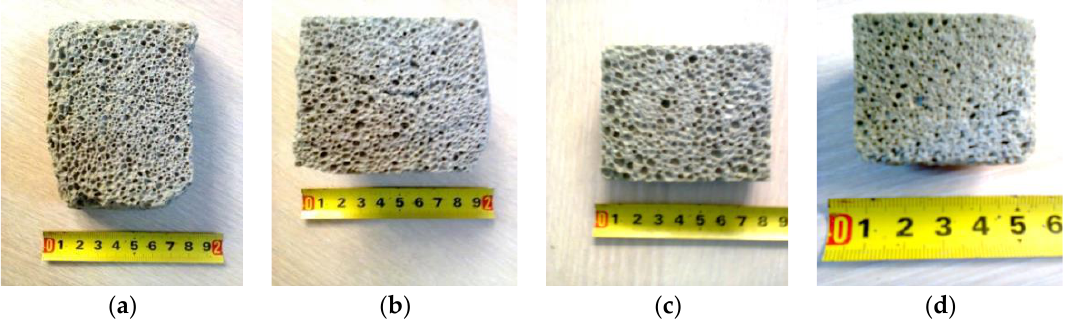
Figure 2. Cross-section appearance of cellular concrete specimens: ( a ) variant 1; ( b ) variant 2; ( c ) variant 3; ( d ) variant 4.